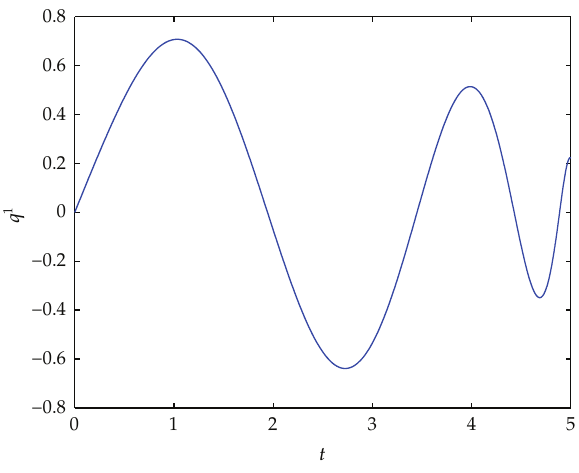
Figure 2: Component q 1 of the